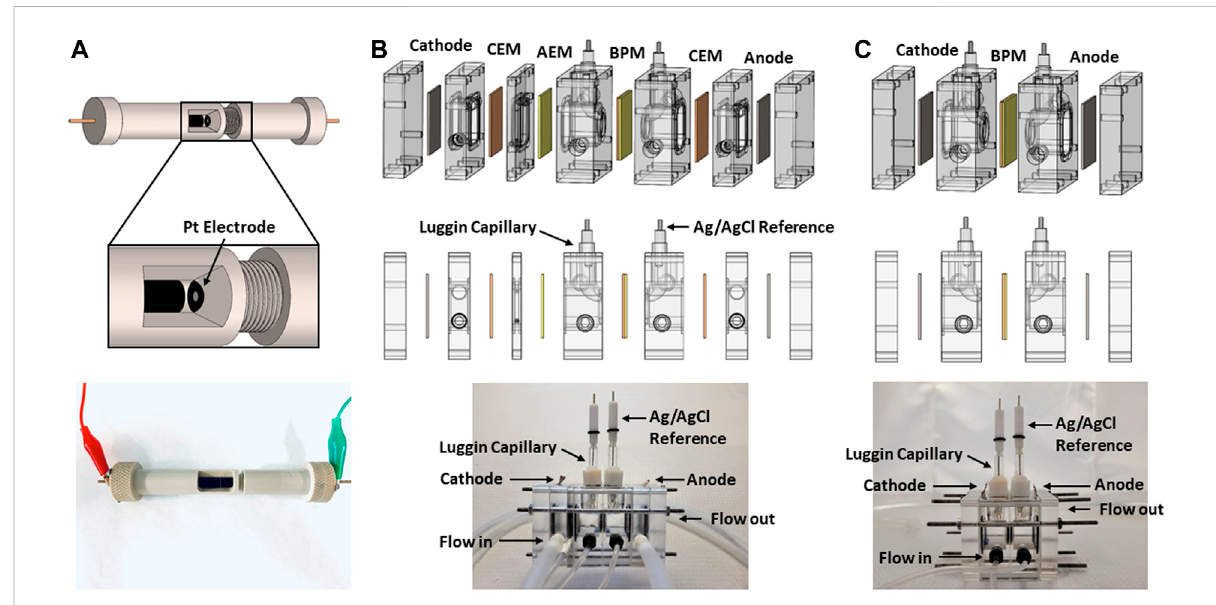
FIGURE 1 Custom cell for EISmeasurements (A) and custom electrodialysis fl owcell for testing BPMs (B,C) . (B) shows fi ve chamber con fi guration and (C) showed two chamber con fi